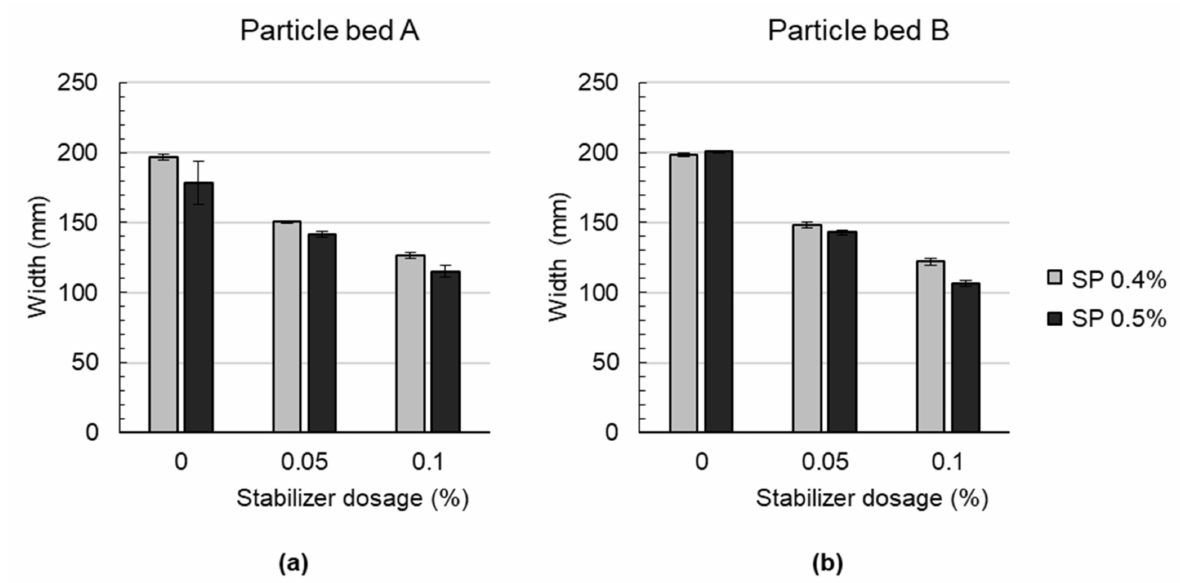
Figure 5. Width of the LP3DCP strands ( a ) with particle bed A and ( b ) particle bed